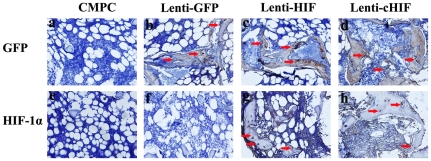
Immunohistochemical analysis of new bone formation in each group in the subcutaneous nude mice.Immunostaining for GFP of (a) CMPC group, (b) Lenti-GFP group, (c) Lenti-HIF group, and (d) Lenti-cHIF group. The GFP, HIF, and cHIF groups show positive brown staining in fibroblastic-like tissue and bone matrix (red arrow). The strong HIF-1α expression was stained in both the bone and the surrounding fibroblastic-like tissue (red arrows) in (g) Lenti-HIF group and (h) Lenti-cHIF group. There was no obvious positive staining in (e) the CMPC group or (f) the Lenti-GFP group (a–h, 400×).